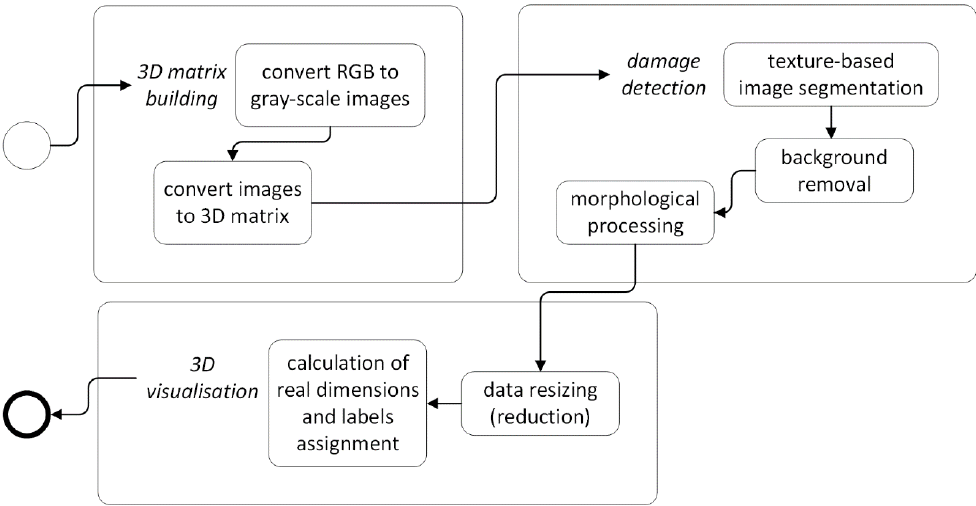
Figure 14. A general reconstruction algorithm for X-ray CT scans.